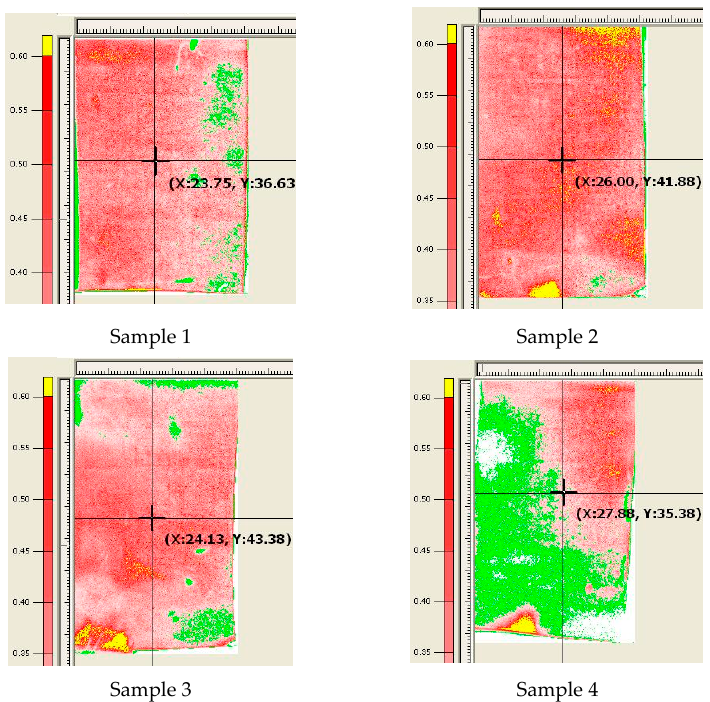
Figure 9. Lamination pressure distribution on four Prescale films. The red color indicates good bonding pressure; the green color with lower pressure leads to bonding failure; the yellow color with higher pressure causes the sidewall deformed. Sample 1 has good lamination on the left half region but not right half region; sample 2 with an uniform and correct pressure is the best among four samples; sample 3 applied uneven pressure leads to good lamination in the central region but not surrounding regions; sample 4 with lower than ideal pressure is the worst.